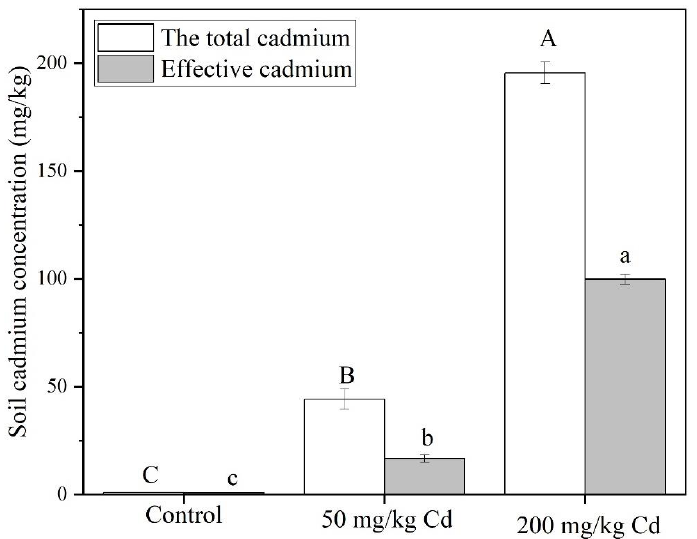
Figure 4. Total Cd and available Cd content of soil in different Cd concentration treatment groups. The data show the means ± SD of three replicates. Different uppercase and lowercase letters show significant differences, p < 0.05.